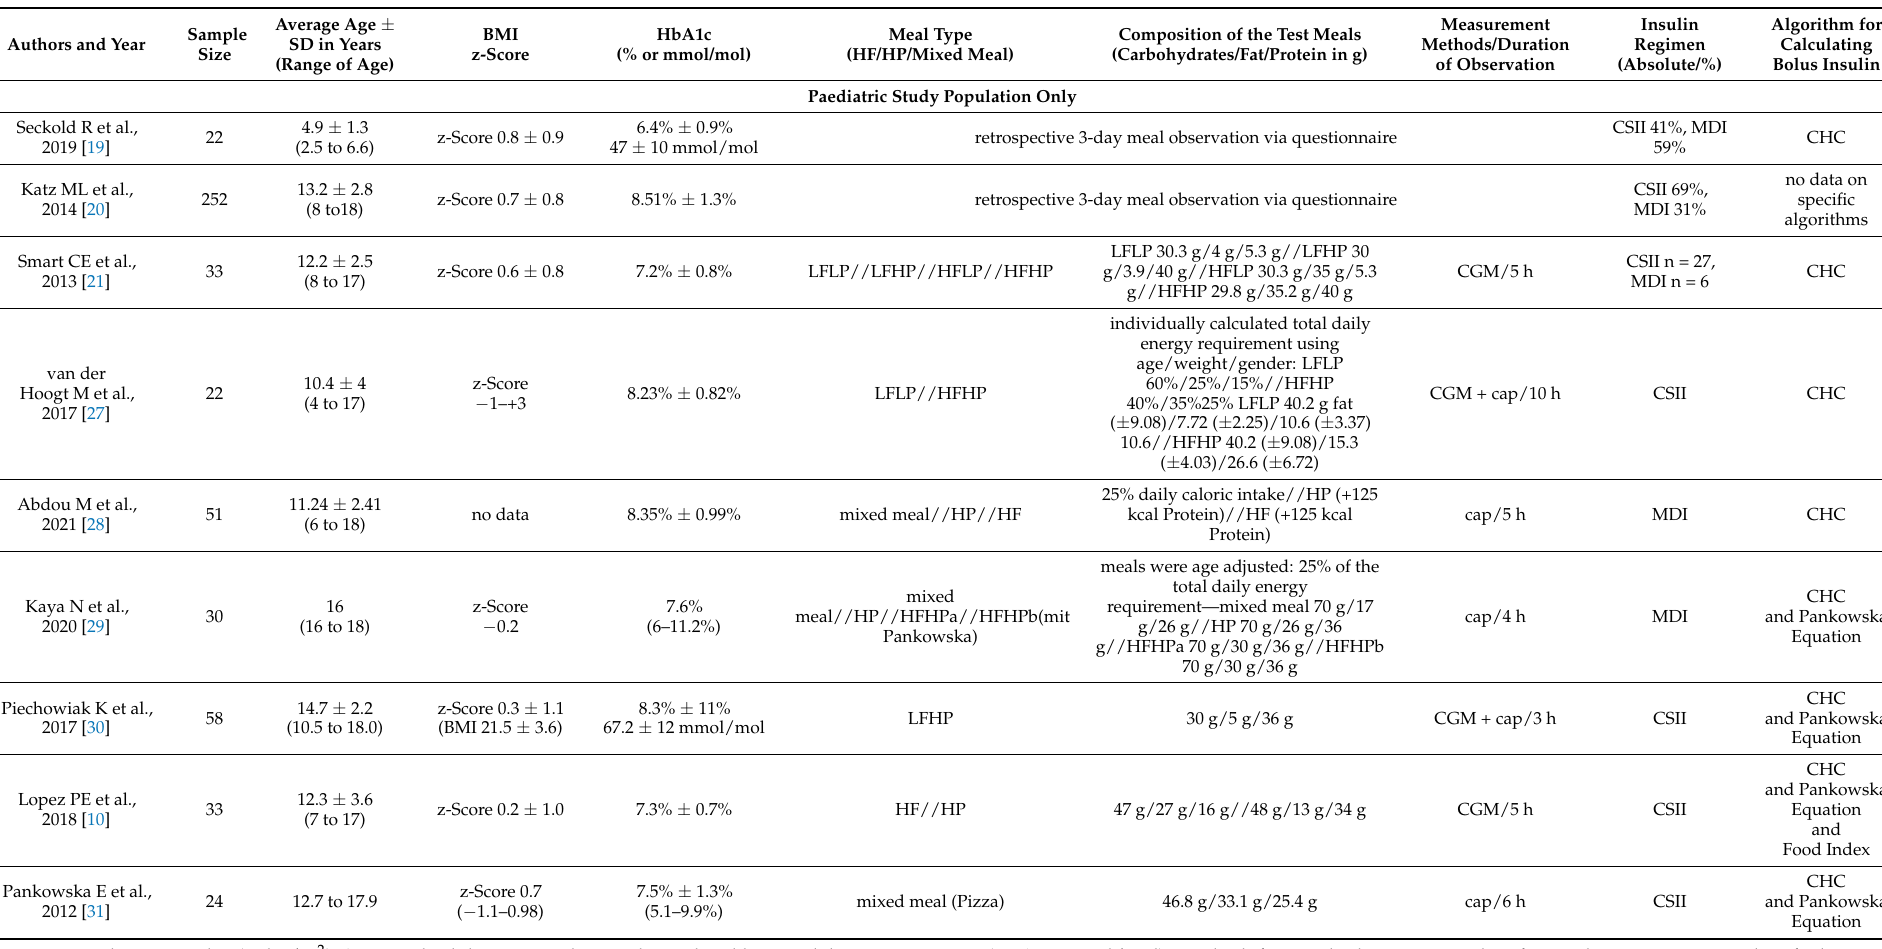
Table 1. Characteristics of reviewed original articles between 1 January 2011 and 1 May 2021 with effect of dietary fat and protein for prandial insulin requirements in children with Type 1